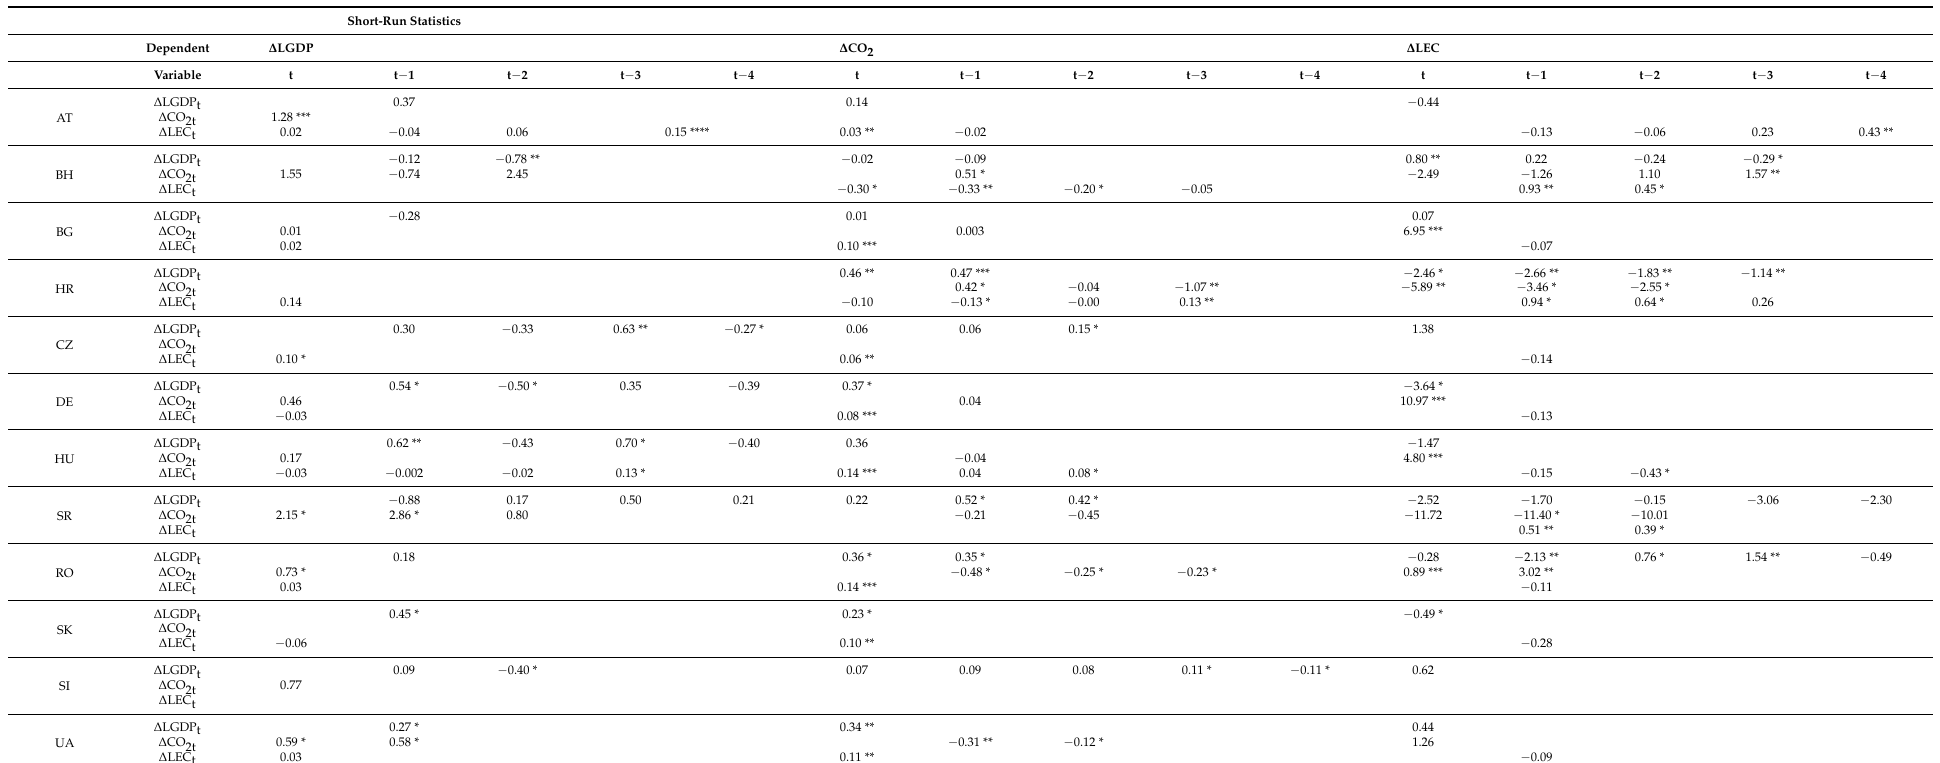
Table 6. Short-run